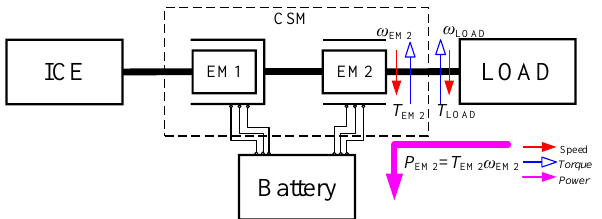
Figure 4. Analysis of power flow in single-motor braking (SMB) mode.